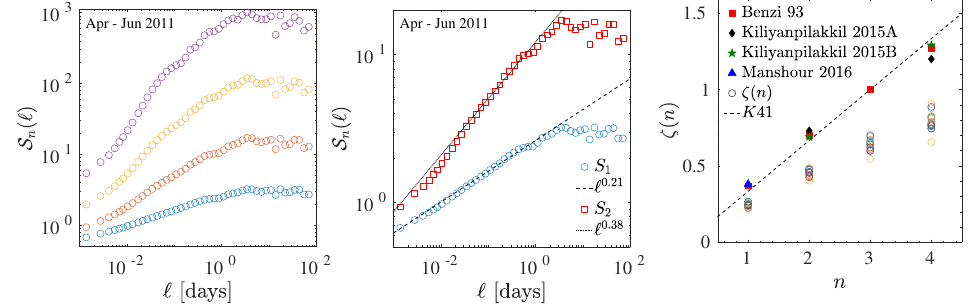
Figure 3. Left panel : Scaling of the structure functions S n ( n = 1 → 4) for sample May–August 2011. Central panel : power-law fit of the first two order structure function; dashed lines represent the theoretical scaling obtained via least squares fit, S 1 ∼ (cid:96) 0.21 ± 0.01 and S 2 ∼ (cid:96) 0.38 ± 0.01 , respectively. Right panel : comparison of scaling exponents ζ ( n ) for orders n = 1 → 4 (circles) for all samples, with respect to other experimental values reported in the literature